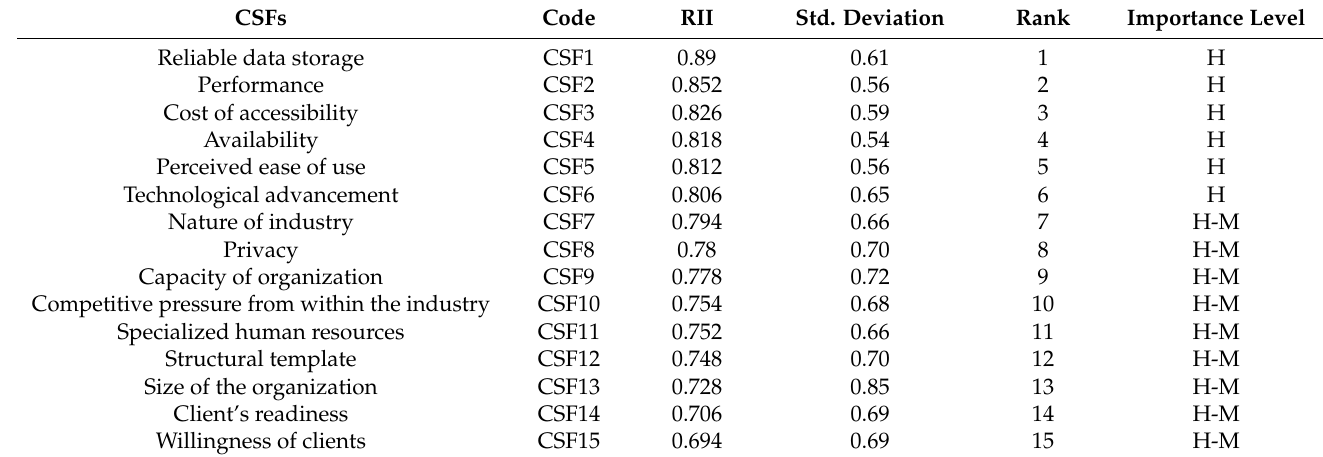
Table 3. The relative importance of cloud computing CSFs.in the Nigerian construction industry.